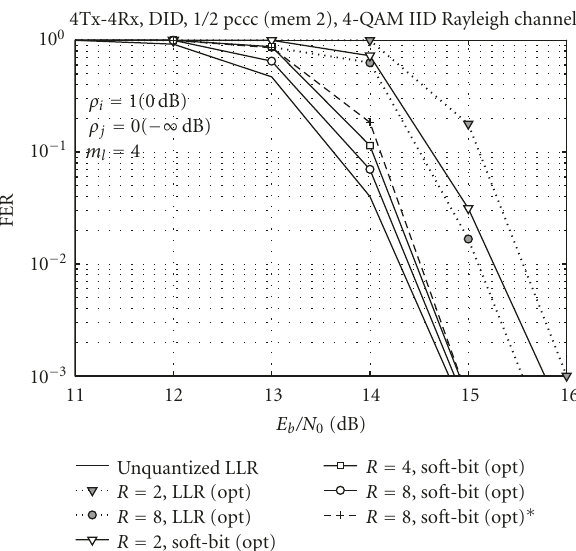
Figure 11: SAIC-DID performance comparison for 2 × 2 and 3 × 3 cells setup. Each MT is received strongly at 4 BSs, while each BS receives signals from 4 MTs. The two curves for 3 × 3 cell setup give the bounds for di ff erent possible combinations of couplings within the setup.